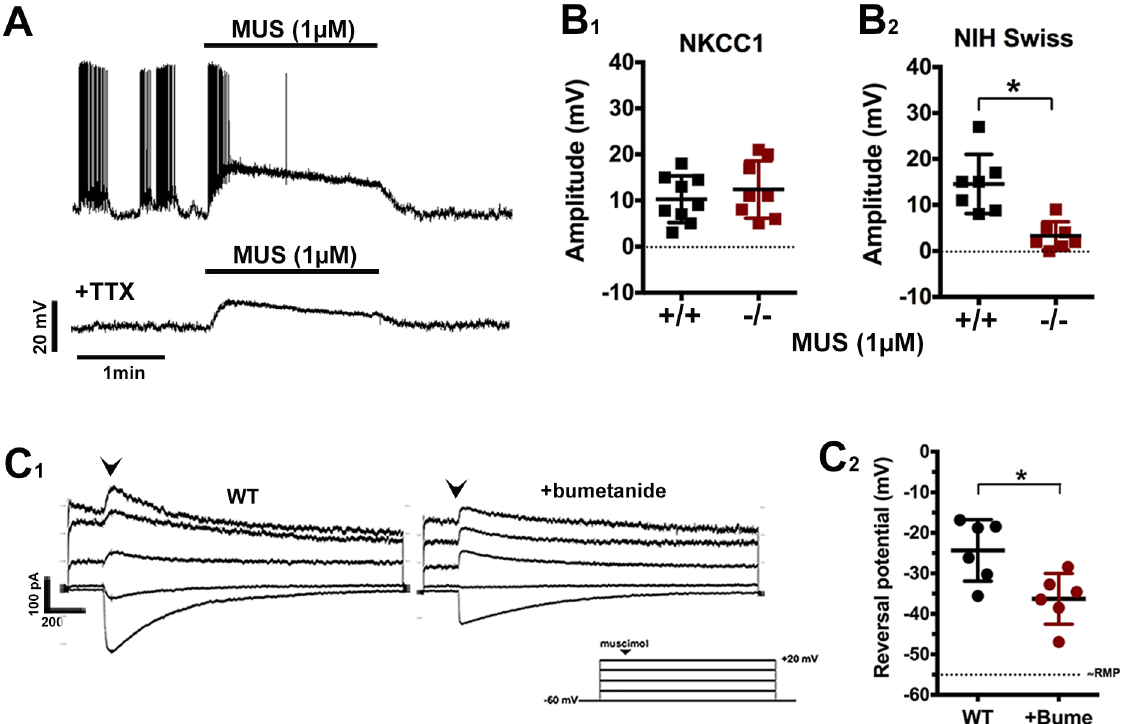
Fig 4. GABA A activation elicits similar response in GnRH neurons from NKCC1 -/- explants but is reduced by BUME. A) Example of a gramicidin perforated patch clamp recording used to measure response to MUS. Trace from NKCC1 -/- GnRH cell shows MUS depolarization is present before and after TTX. B) Peak amplitudes of MUS responses in GnRH neurons are similar in NKCC1 +/+ (+/+, black dots) and NKCC1 -/- (-/-, red dots) (B1) In contrast, BUME treatment significantly reduces the response to MUS in GnRH neurons in WT mice (B2). C) Reversal potential for GABA in GnRH neurons was evaluated by acute application of MUS (100 μ M, arrowhead). All recordings were performed with CNQX/AP5 (10 μ M each) and TTX (1 μ M). Examples of recordings from GnRH neurons in untreated (WT) and bumetanide treated (+BUME) groups, and the voltage protocol used (C1). Reversal potentials were more negative when NKCC1 was inhibited by BUME (20 μ M, red dots) than in control (WT, black dots) cells ( * p < 0.05, error bars = SEM)